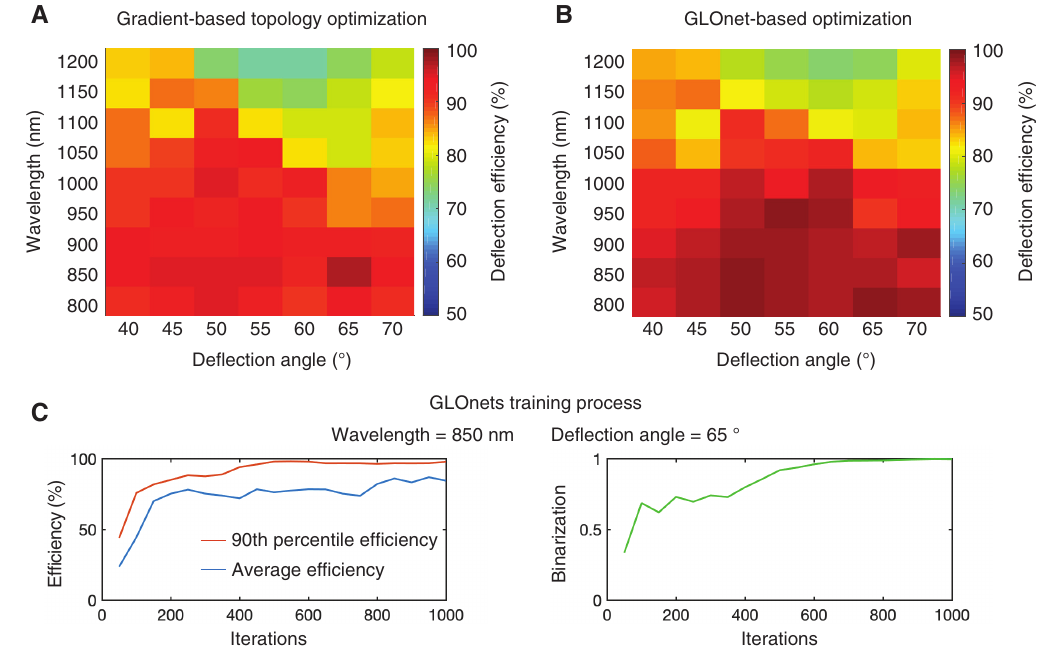
Figure 4: Summary of GLOnet performance. (A) Plot of efficiency for devices operating with different wavelength and angle values, designed using gradient-based topology optimization. For each wavelength and angle combination, 500 individual topology optimizations are performed and the highest efficiency device is used for the plot. (B) Plot of efficiency for devices designed using GLOnet-based optimization. For each wavelength and angle combination, 500 devices are generated and the highest efficiency device is used for the plot. (C) Training process of GLOnets. The figure on the left shows the 90th percentile efficiency and average efficiency of the device batch over the course of training. The figure on the right shows the binarization degree of generated devices, which is defined as